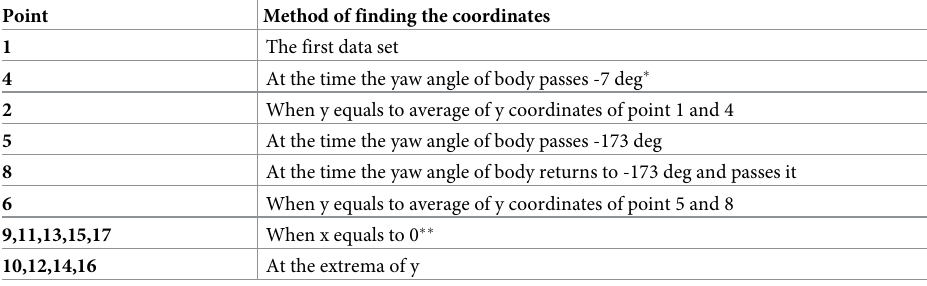
Table 1. Method of finding the location of measurement